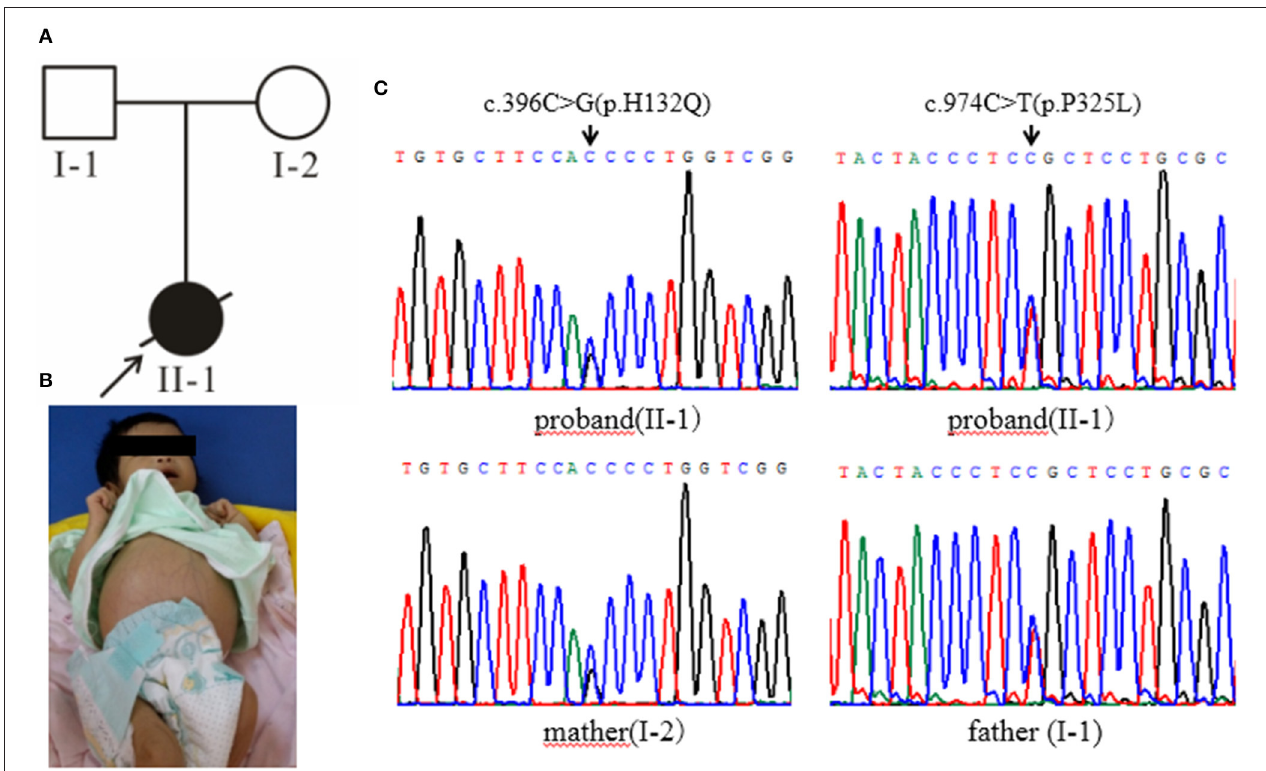
FIGURE 1 | (A) The black arrow indicates the proband, and the slash indicates the proband has died. (B) The clinical manifestations of the proband: yellow skin, dark yellow color, abdominal distention, and abdominal wall vein filling. (C) Gene sequencing results: the proband carries the GALT gene c.396C > G (p.His132Gln) and c.974C > T (p.Pro325Leu) complex heterozygous mutation, c.396C > G (p.His132Gln) from the maternal source, and c.974C > T (p.Pro325Leu) from the paternal